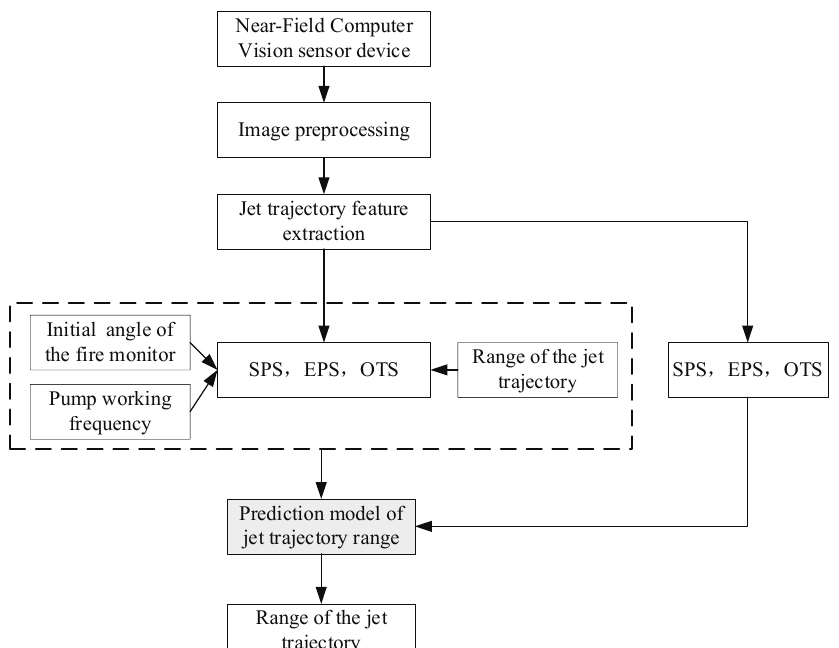
Figure 9. The experiment platform of the NFCV